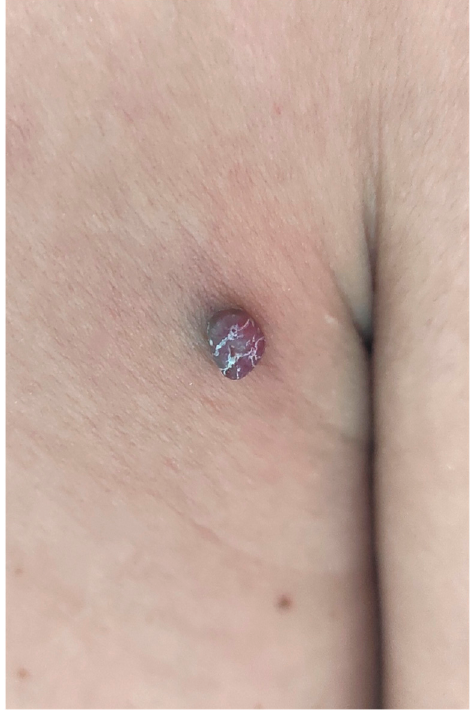
Figure 1. Erythematous nodular lesion on the back.